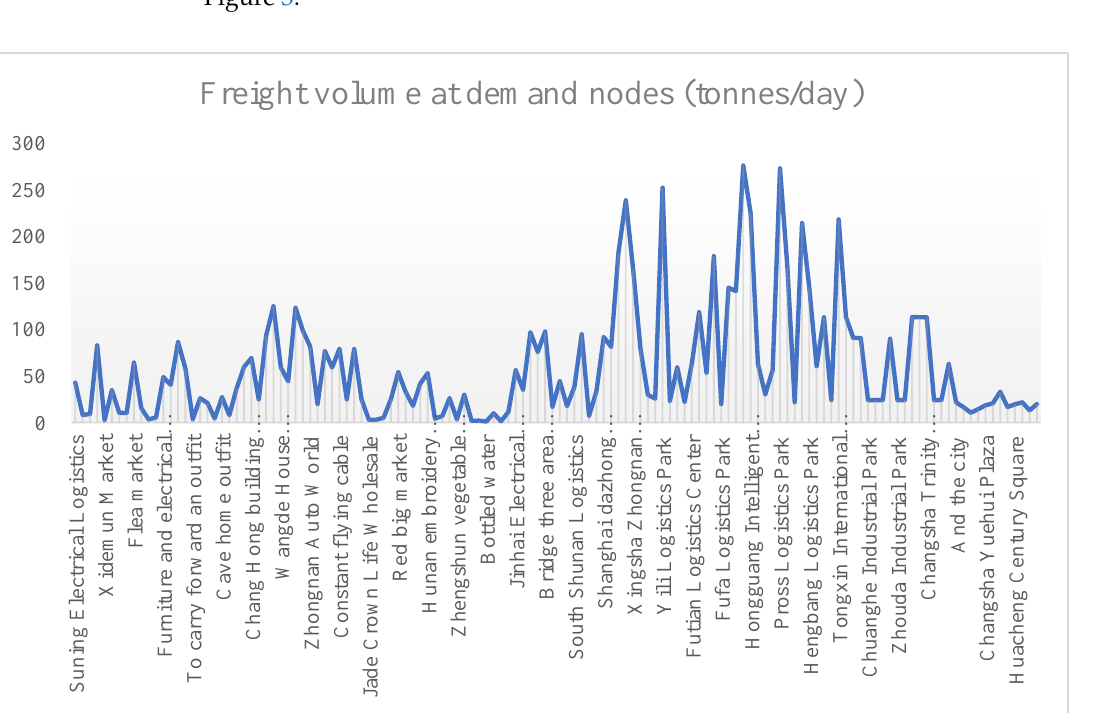
Figure 3. Freight volume distribution map of demand nodes in Changsha City.